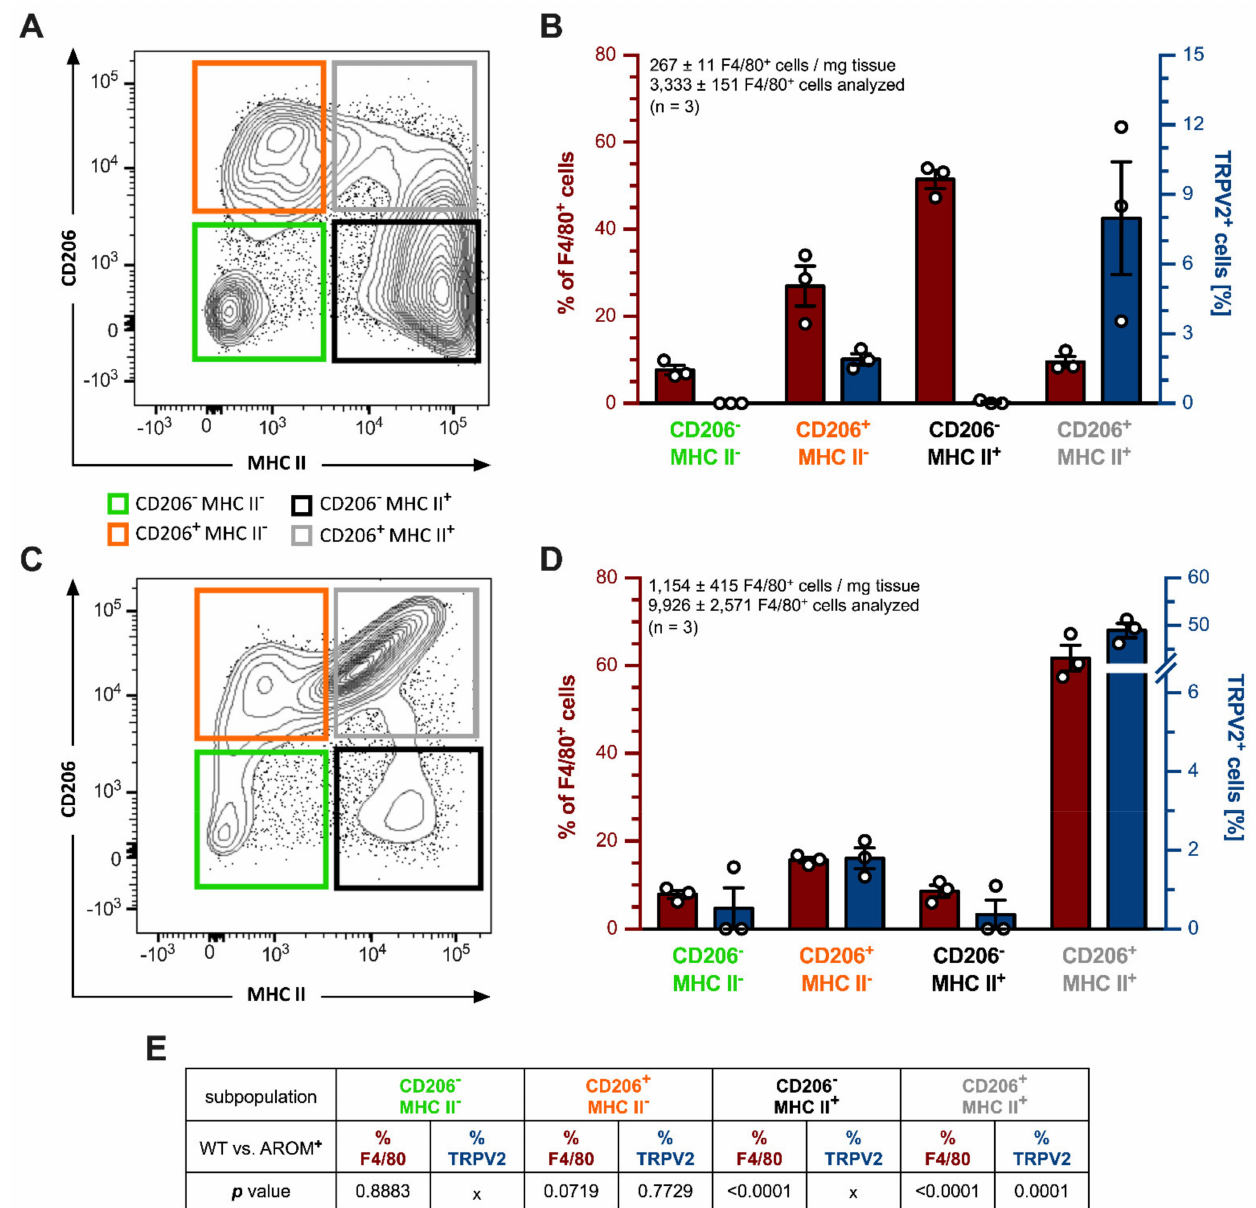
Figure 4. Flow cytometry analysis of testicular macrophage populations of young WT and AROM + mice. Cells from 3 month-old WT and AROM + testes ( n = 3, each) were isolated, processed for FACS analysis and sorted for macrophage markers (CD45 + CD11b + F4/80 + ), and further divided by CD206 and MHC II expression. TRPV2 expression was quantified within the resulting subpopulations. ( A , C ) Representative two-dimensional plots of a WT ( A ) and AROM + animal ( C ), showing the four subpopulations depending on their CD206 and MHC II expression level (green—CD206 - MHC II - , orange— CD206 + MHC II - , black—CD206 - MHC II + , gray—CD206 + MHC II + ). ( B , D ) Quantitative analyses of testicular macrophage subpopulations in WT and AROM + mice. The percentages of total F4/80 + cells (red axis), and TRPV2 + cells within these particular subpopulations (blue axis) are shown. The graphs represent mean ± SEM. ( E ) Results of statistical analysis ( p values) of the particular subpopulations (% of F4/80 + ) and the corresponding percentage of TRPV2 + cells (TRPV2 + cells [%]) within these subpopulations of WT and AROM + animals, using an unpaired two-tailed t -test, α = 0.05, where Gaussian distribution is given and proteins could be detected in all replicates (3/3).